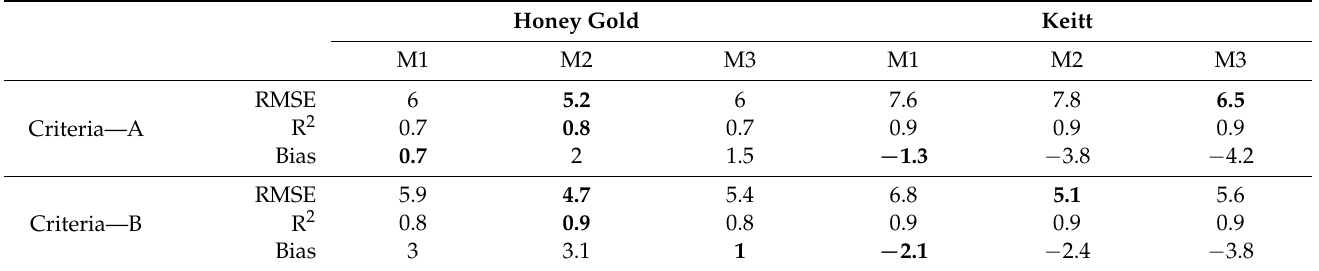
Table 8. Statistics of RMSE, R 2 and bias on estimation of fruit length using three methods